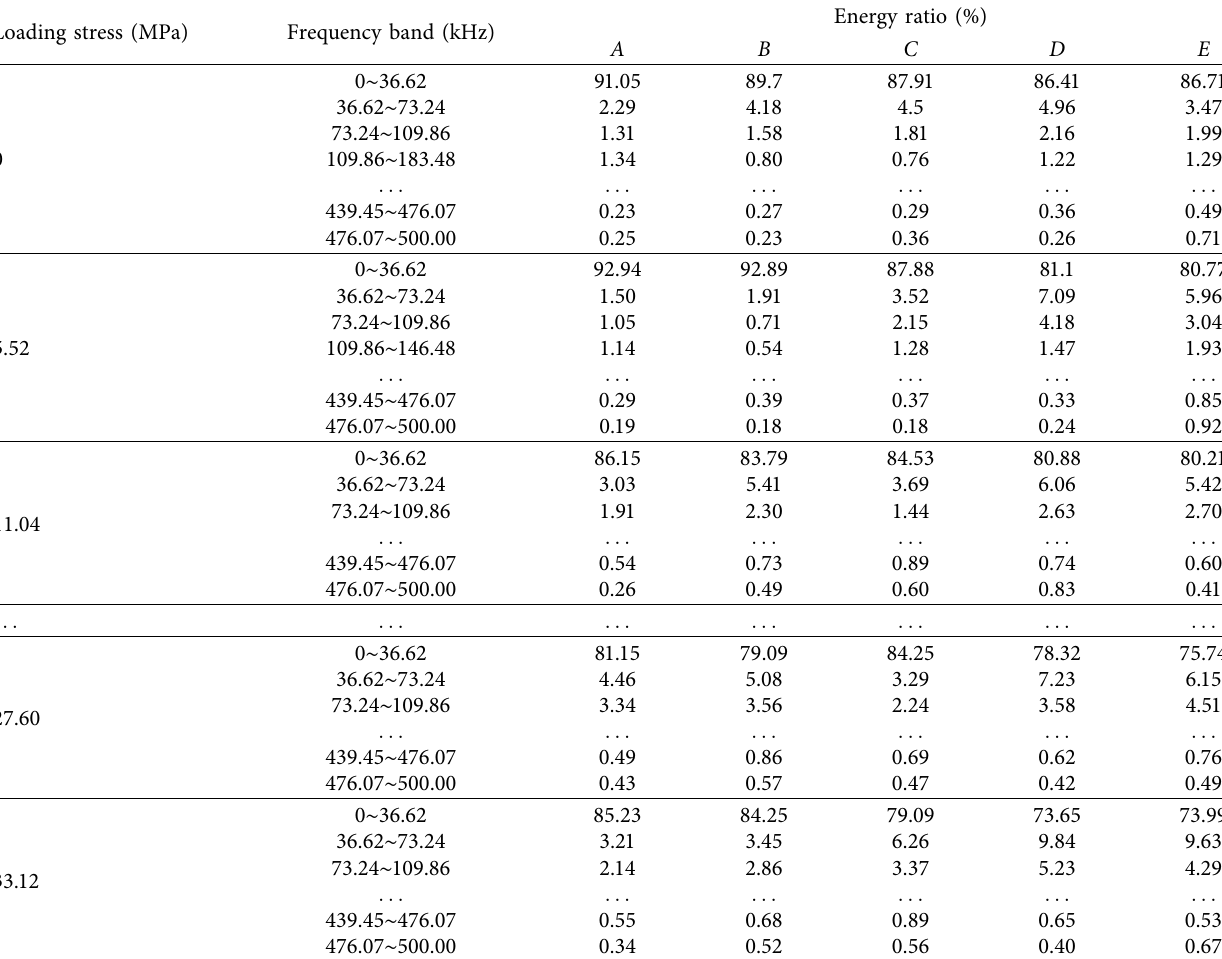
Table 4: Energy ration of frequency